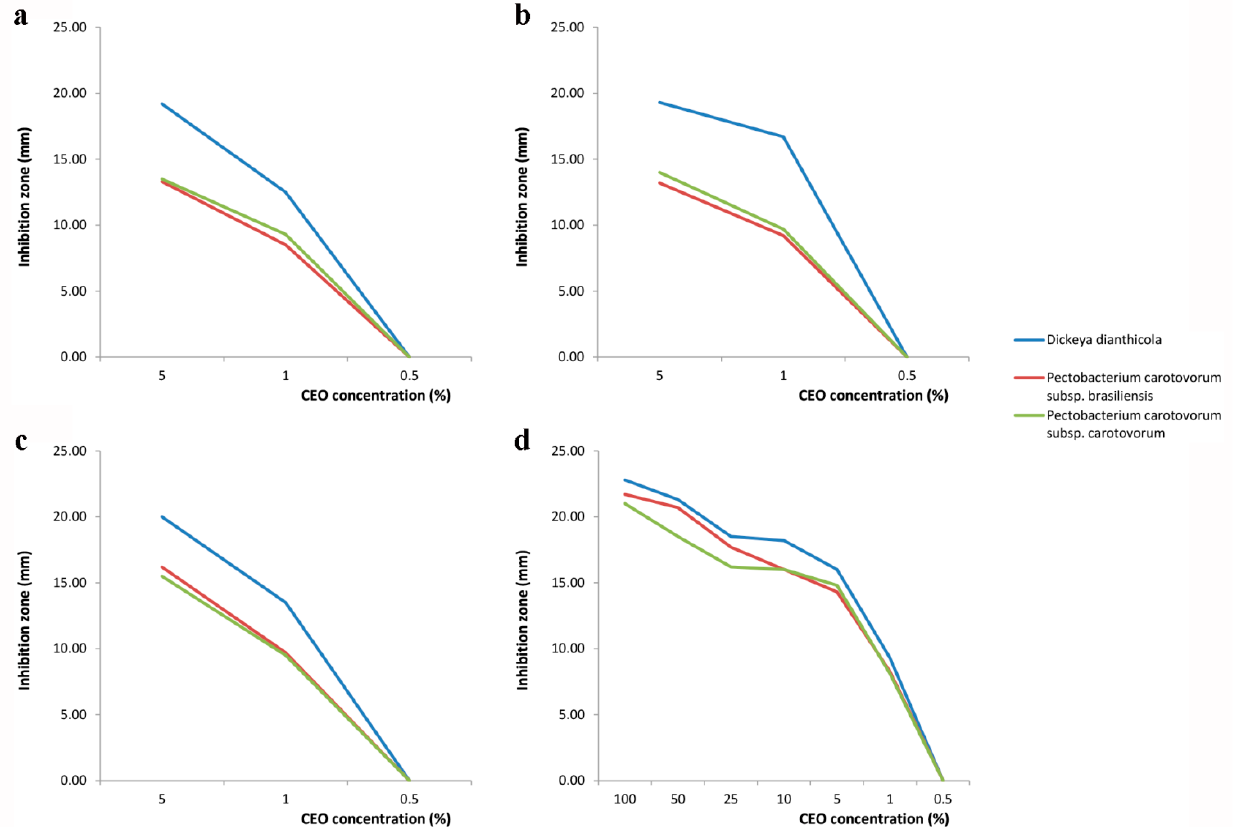
Figure 1. In vitro antibacterial activity of encapsulated and pure CEO against soft rot bacteria; ( a ) F-CNZ; ( b ) F-CSZ; ( c ) F-CG; ( d ) pure CEO.